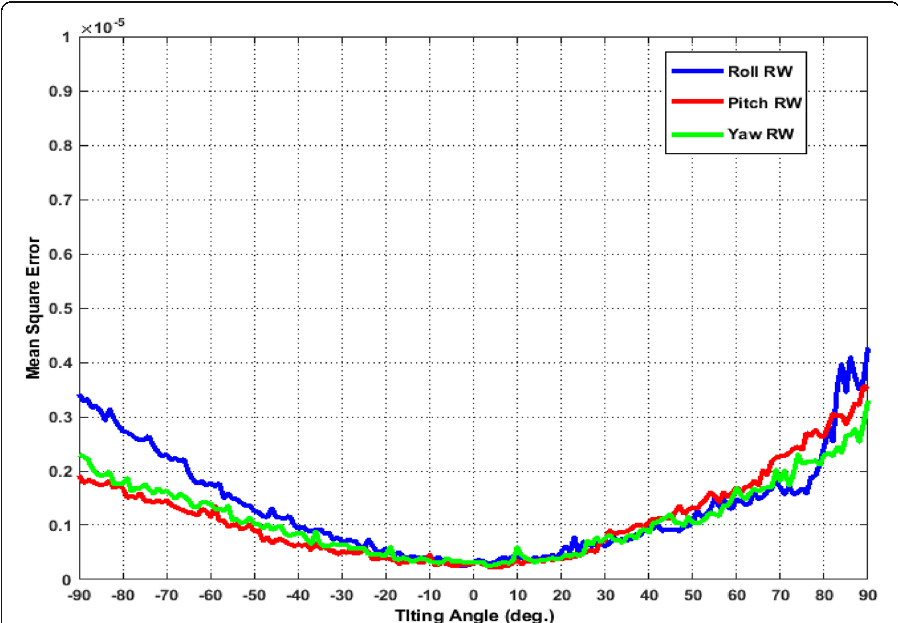
Fig. 9 Performance of the developed RW models measured at tilting angle from − 90° to 90° roll, pitch, and